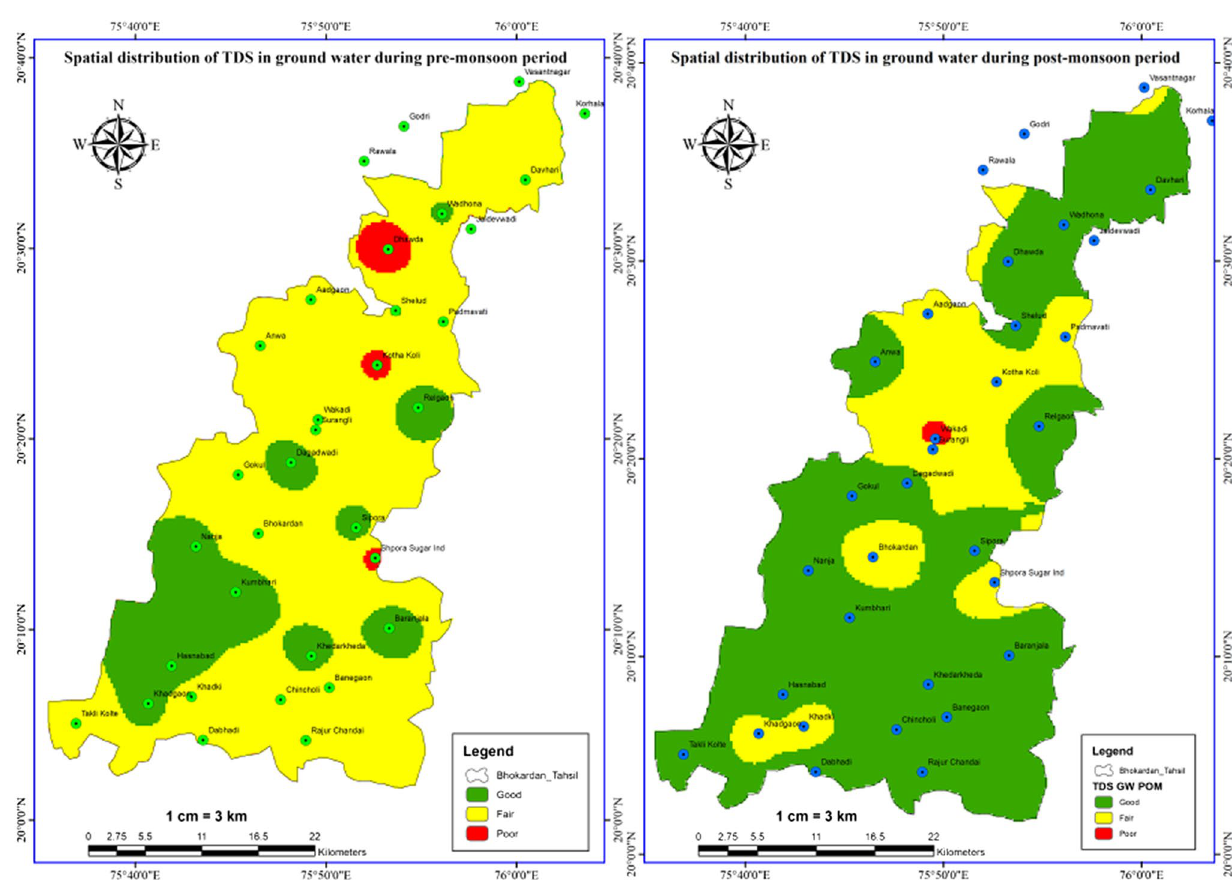
Fig. 2 Spatial distribution of TDS in ground water during pre and post-monsoon